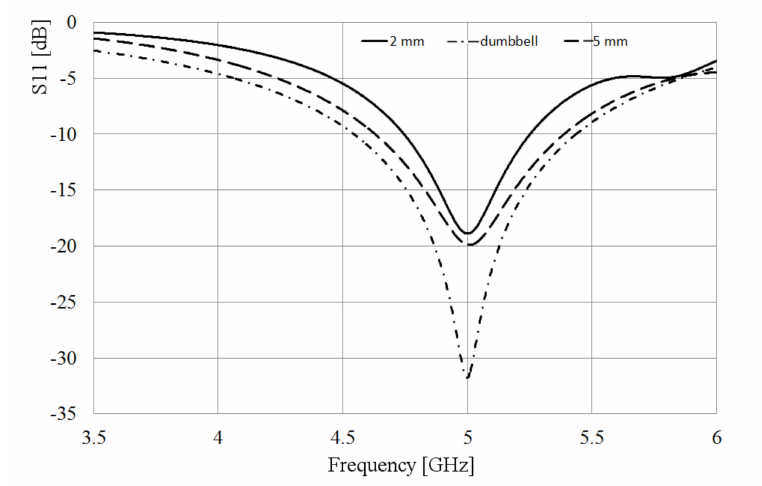
Figure 2. Simulated S11 parameter of the slot for different widths.